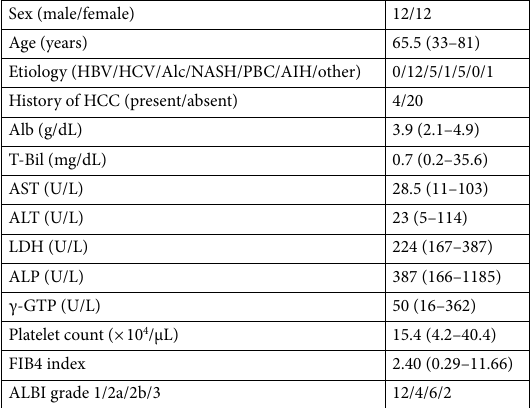
Table 3. Patient background and laboratory data at the evaluation of pruritus in 24 patients with intractable pruritus. Laboratory data are expressed as median (range) values. AIH autoimmune hepatitis, HBV hepatitis B virus, HCV hepatitis C virus, Alc alcoholic hepatitis, NASH non-alcoholic steatohepatitis, PBC primary biliary cholangitis, HCC hepatocellular carcinoma, ALBI grade albumin–bilirubin